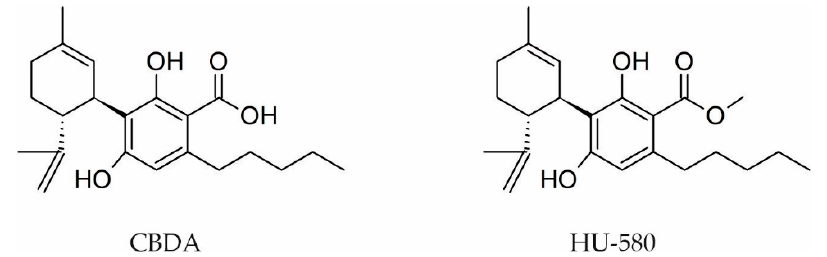
Figure 3. Chemical structure of CBDA derivative HU ‐ 580.